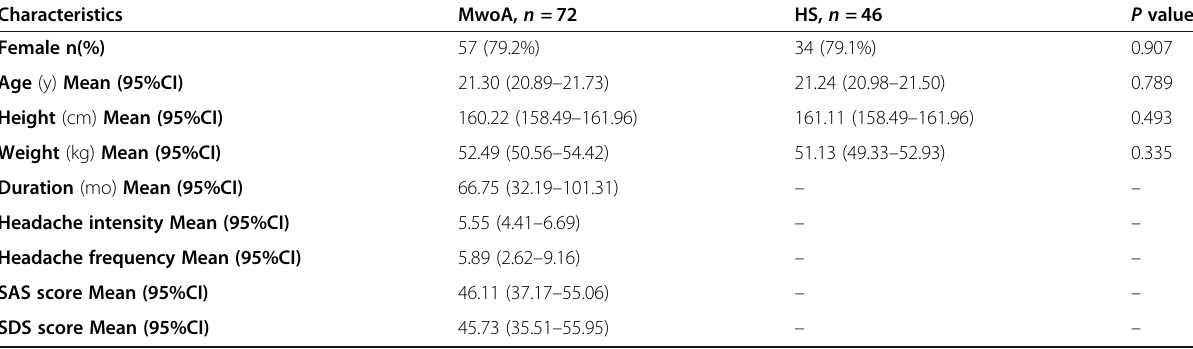
Table 1 Baseline characteristics of MwoA patients and healthy subjects